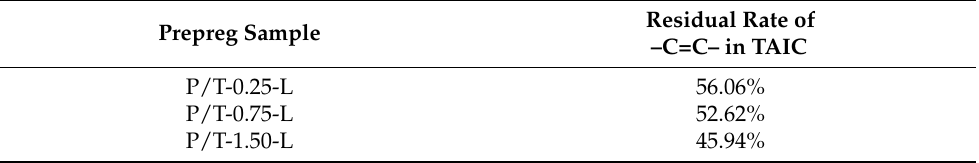
Table 8. Residual rate of –C=C– in TAIC of different prepreg